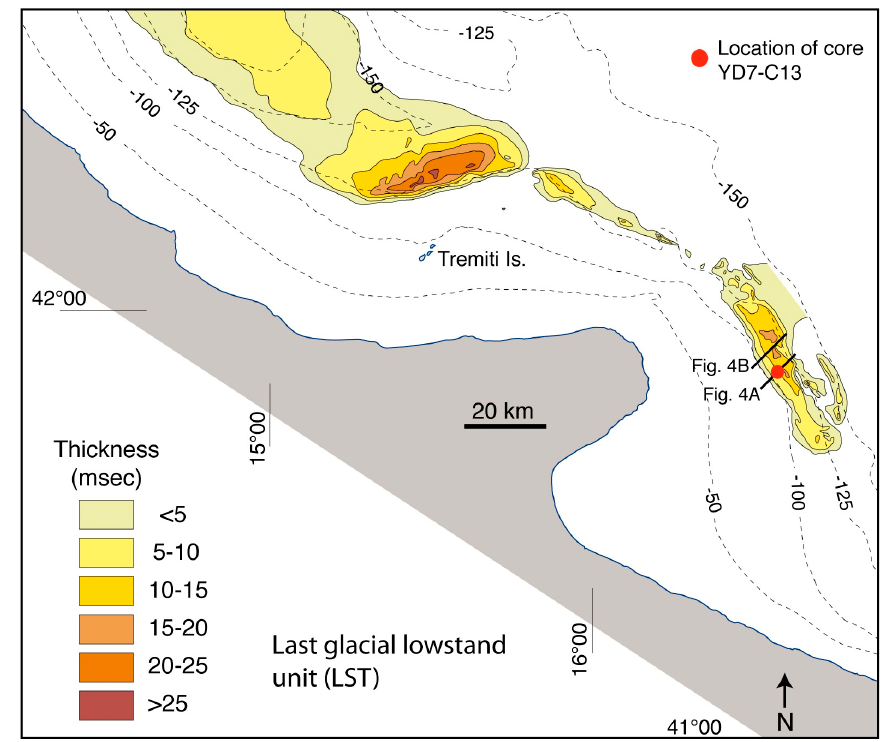
Figure 5. Isochronopachs (1 msec ≅ 0.75 m in the investigated interval) of the last glacial LST